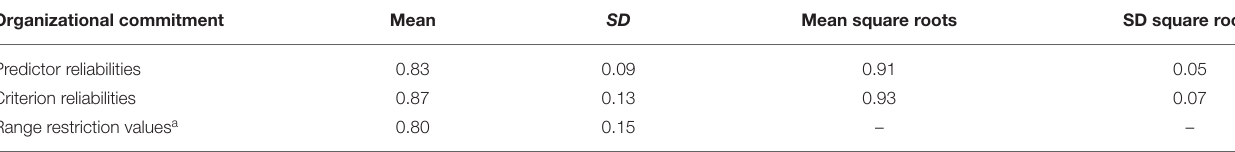
TABLE 2 | Descriptive statistics of artifact distributions for correcting validities.